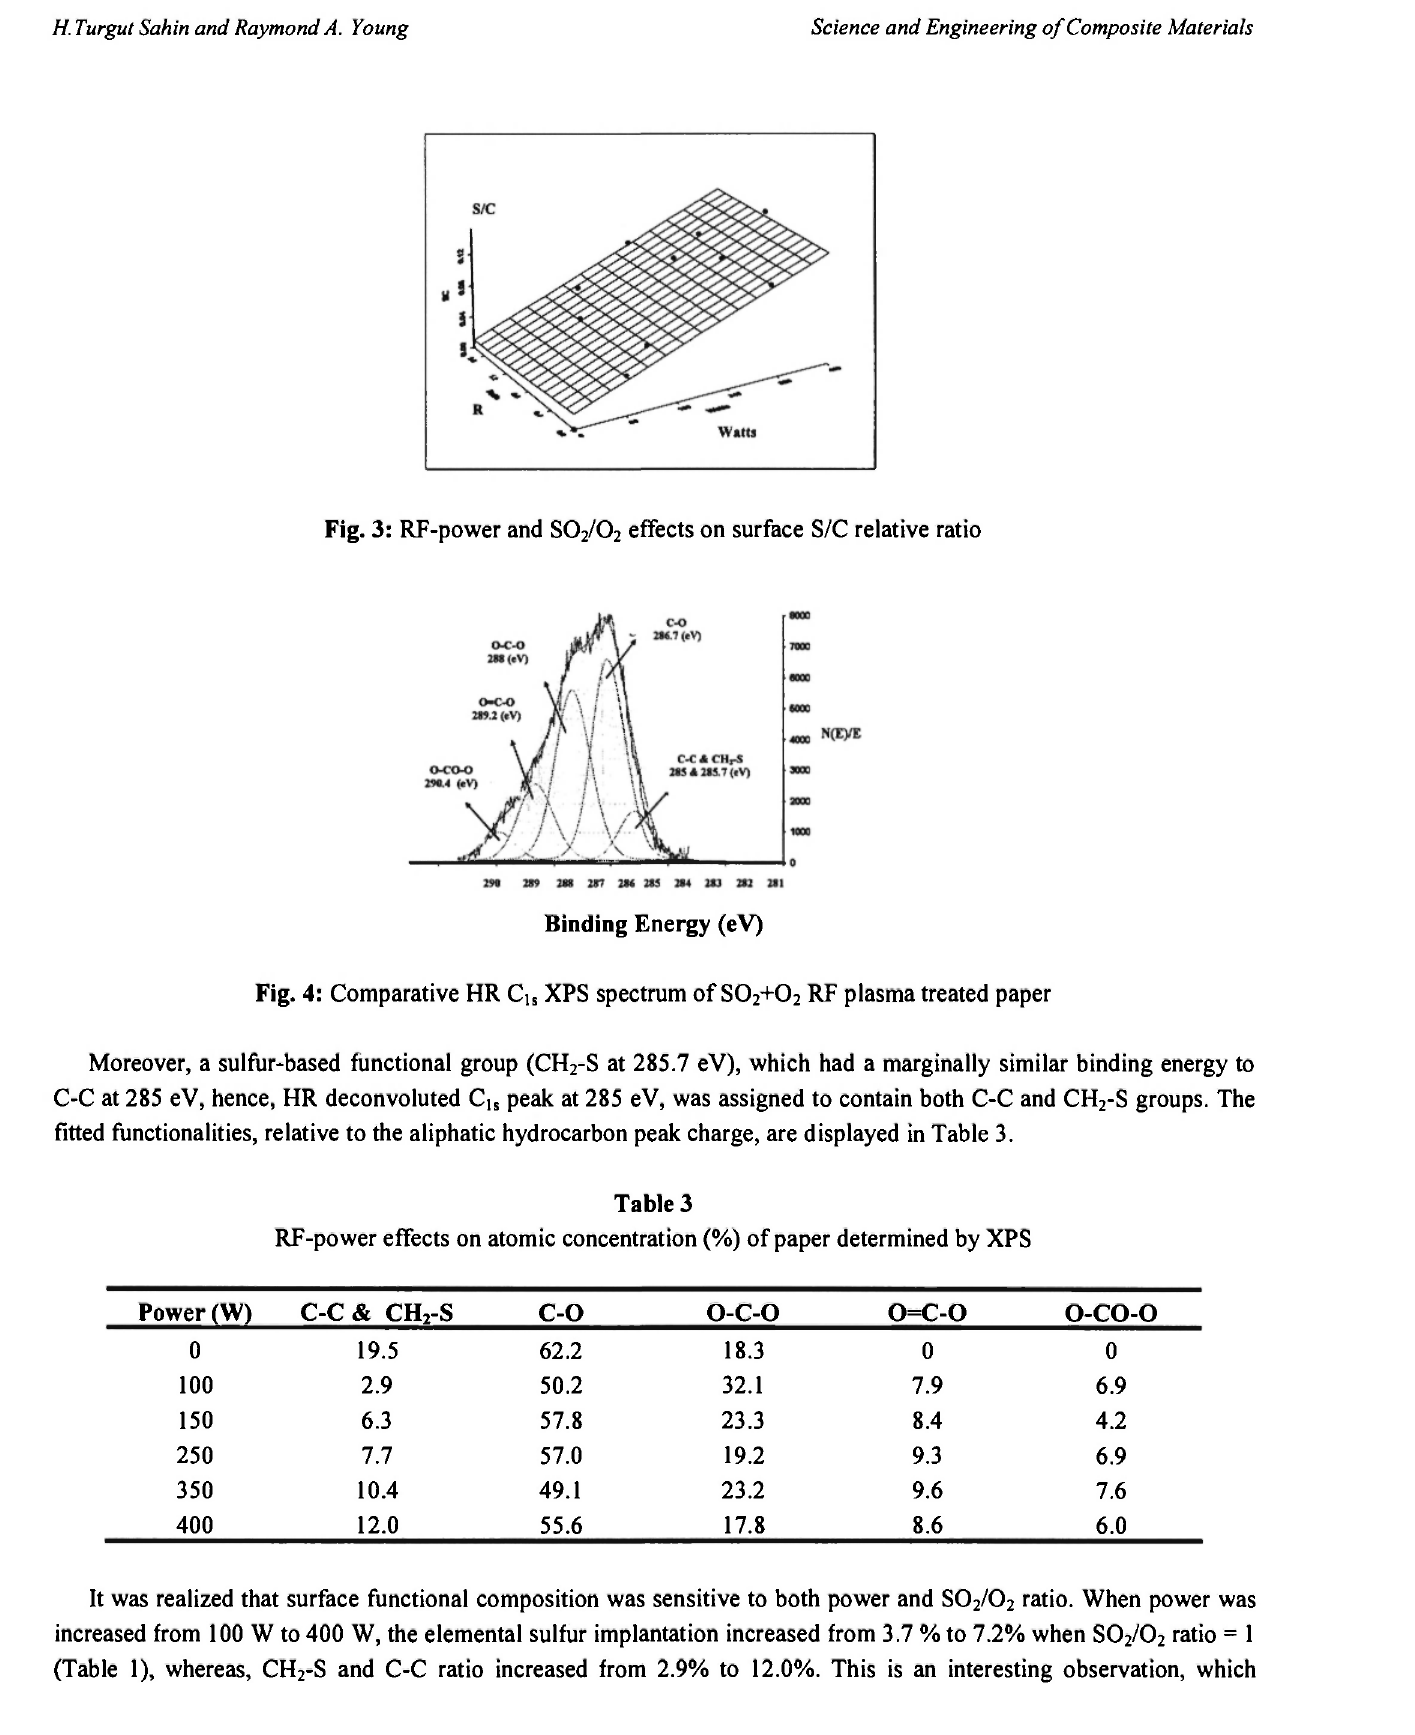
Fig. 3: RF-power and S0 2 /0 2 effects on surface S/C relative ratio